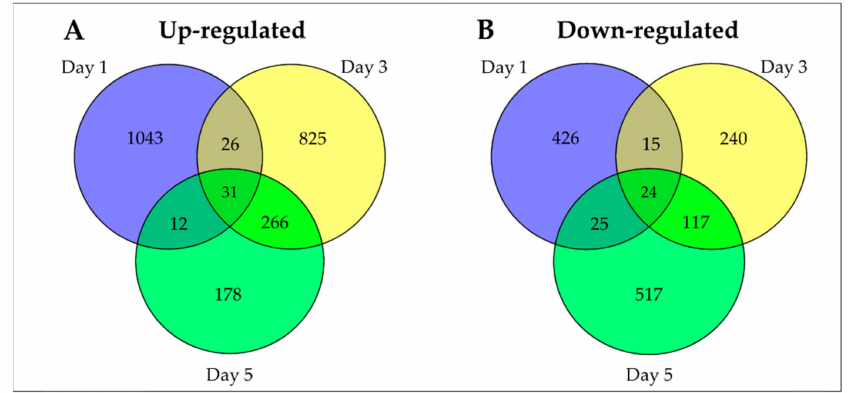
Figure 3. The Venn diagram showing the overlapping upregulated differentially expressed genes (DEGs) ( A ) and downregulated DEGs ( B ) in +UVB compared to − UVB during leaf development of rice